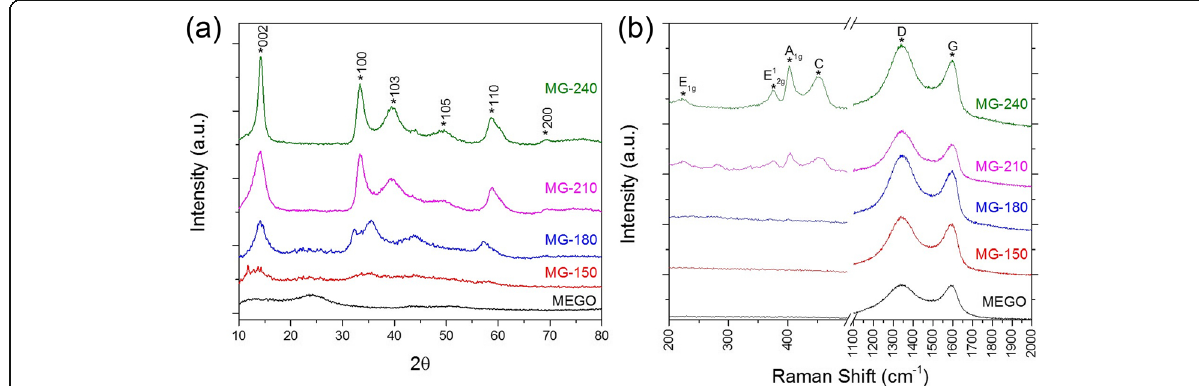
Fig. 2 Crystallization comparison of MoS 2 /graphene hybrids. a XRD spectra of MoS 2 /graphene hybrids prepared at 150, 180, 210, and 240 °C compared with MEGO, ( b ) Raman spectra of MoS 2 /graphene hybrids and MEGO. 2H peaks of MoS 2 are labeled in the